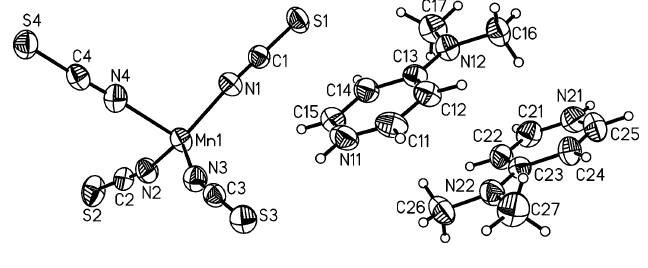
Figure 2 View of the asymmetric unit of 1 , with atomic labelling and displacement ellipsoids drawn at the 50% probability level.